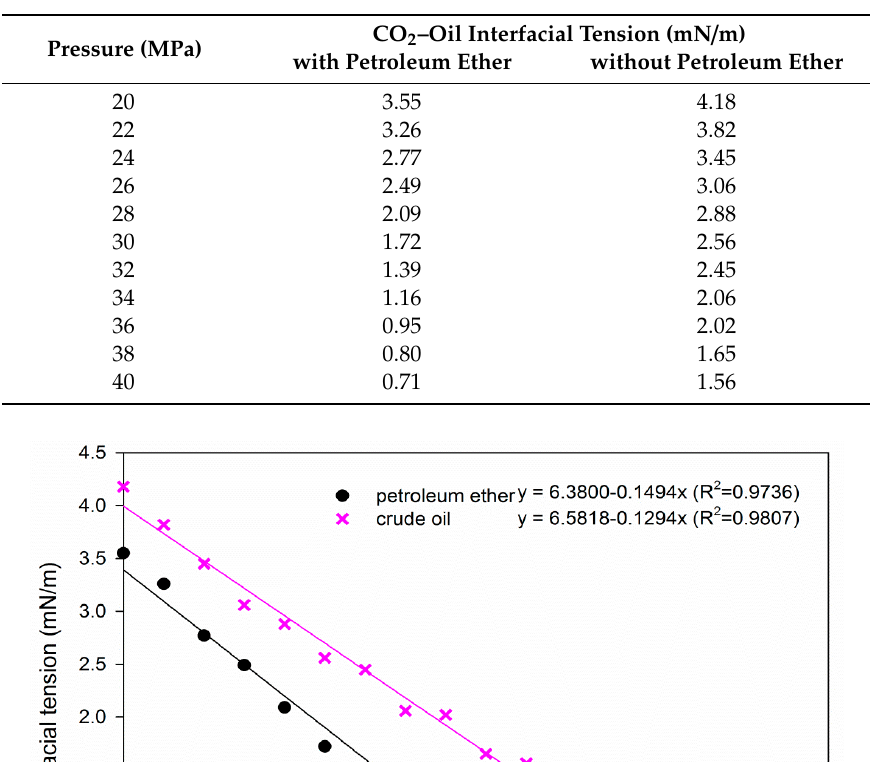
Table 2. Calculated CO 2 –oil interfacial tensions under di ff erent pressures.